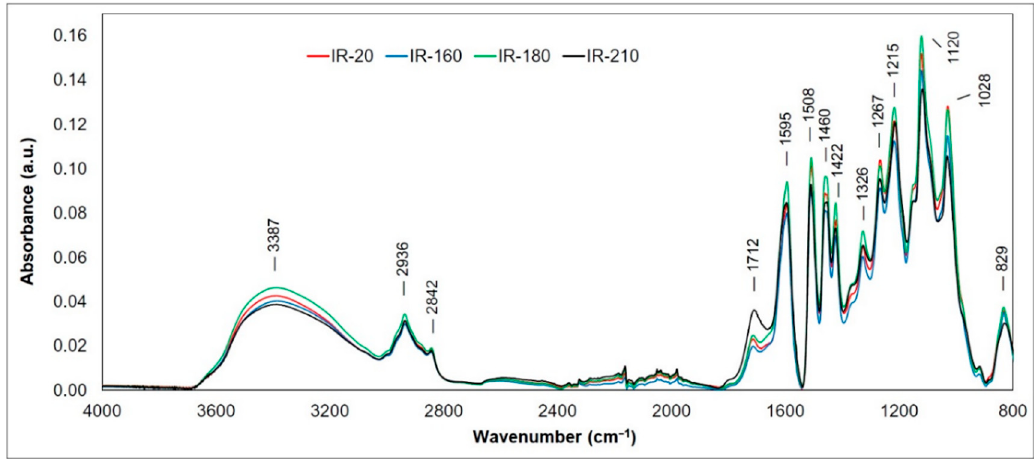
Figure 4. FTIR spectra of the untreated and thermally modified iroko wood lignin.